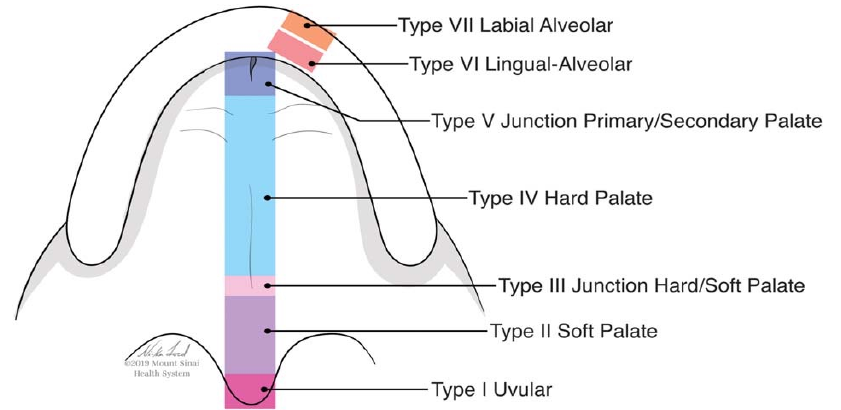
Figure 1. The Pittsburgh Fistula Classification System for palatal fistulae (Adapted with permission from [1]. Copyright year 2007, Darren M Smith.).